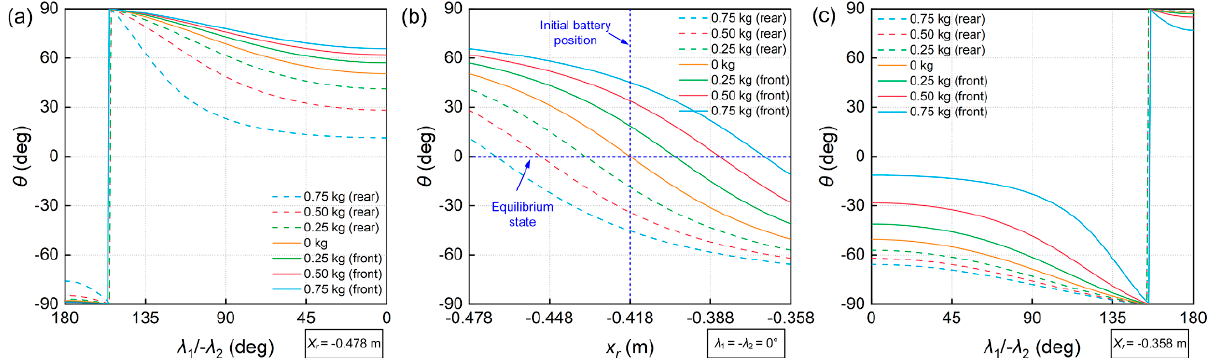
Figure 14. The regulation range of θ at different ballast masses: ( a ) θ vs. λ 1 / − λ 2 ( x r = − 0.478 m); ( b ) θ vs. x r ( λ 1 / − λ 2 = 0°); ( c ) θ vs. λ 1 / − λ 2 ( x r = − 0.358 m). Table 4. The mass of ballast for regulating x g.